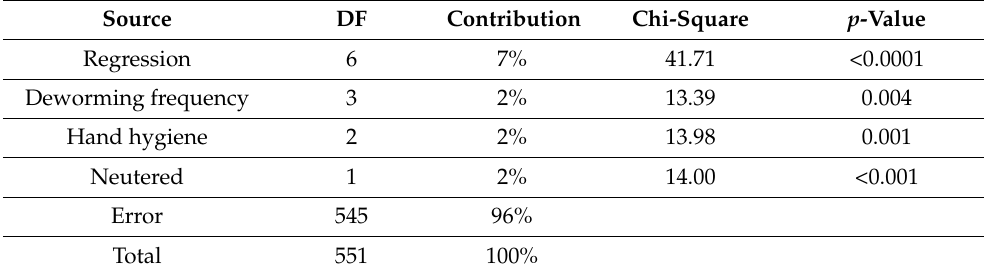
Table 8. Binary logistic regression analysis for factors that differed for owners who obtained their dog before or during the